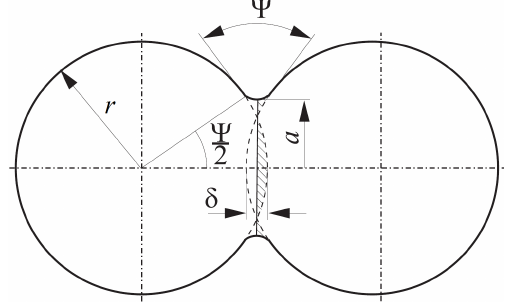
Figure 3. Two-particle model of